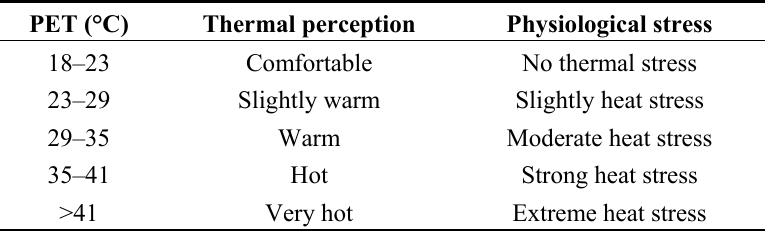
Table 3. Physiologically equivalent temperature (PET) range for different grades of human thermal perception and associated physiological stress